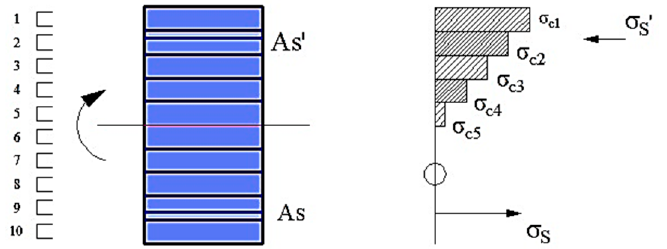
Figure 12. Cross-section for ( a ) Reinforced concrete beam and ( b ) non-linear Shell element.